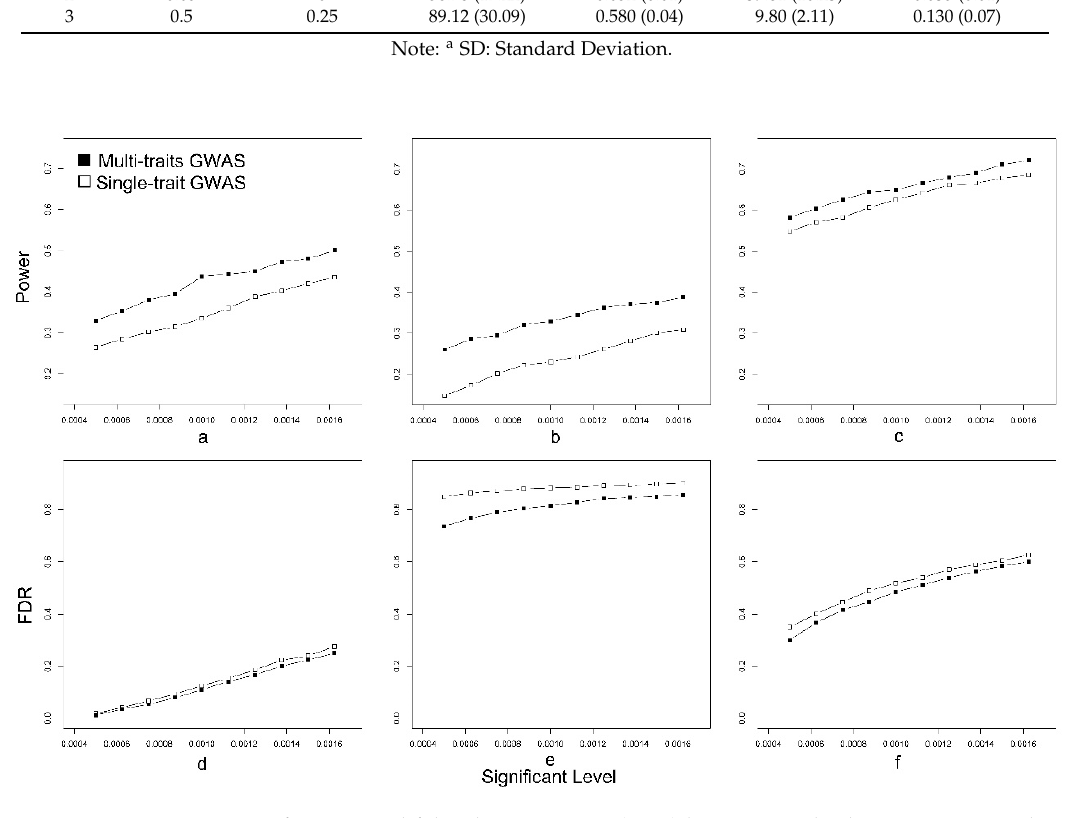
Figure 2. Comparison of power and false discovery rate (FDR) between multiple-trait GWAS and single-trait GWAS. We simulated three situations including medium heritability ( a , d ), low heritability ( b , e ), and environmental correlation ( c , f ). ( a – c ) Power under different significant levels. ( d – f ) FDR under different significant levels.